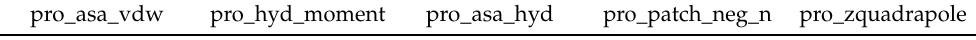
Table 5. Common selected features between ADORA2A and OPRK1 having a feature score of 3.